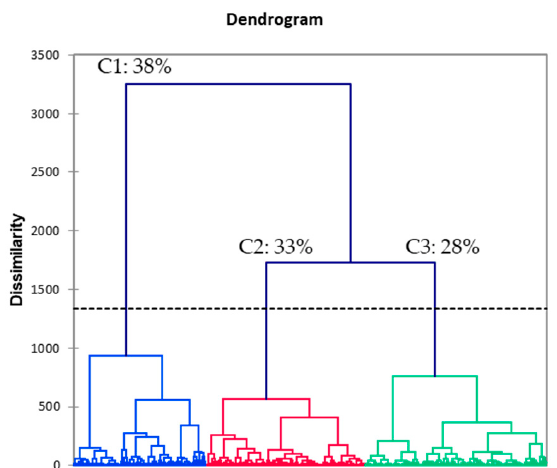
Figure 5. HCA dendrogram plot shows percent observation membership within each cluster (C). C1 = Cluster 1, C2 = Cluster 2, C3 = Cluster 3. Blue, red, green colors represent different cluster membership.